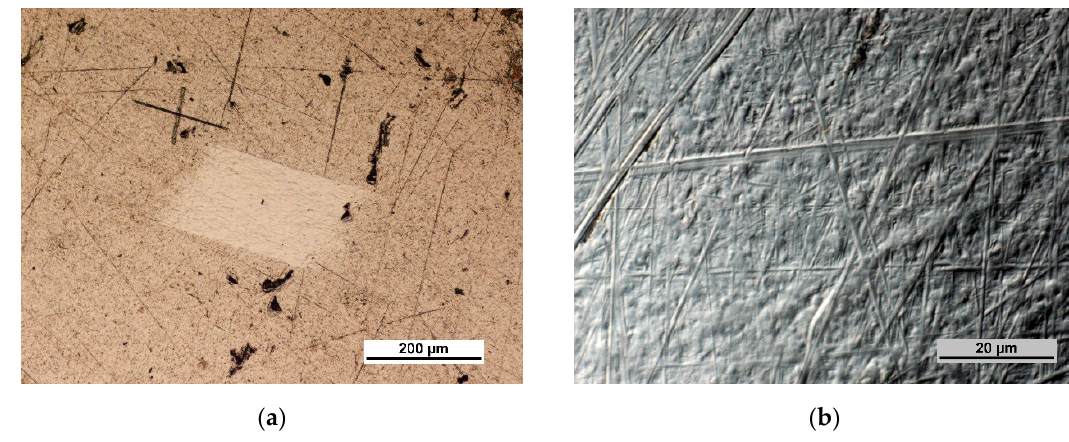
Figure 3. Ti6Al4V titanium alloy surface: ( a ) In polarized light at 50× magnification; ( b ) DIC image at 1000× magnification.